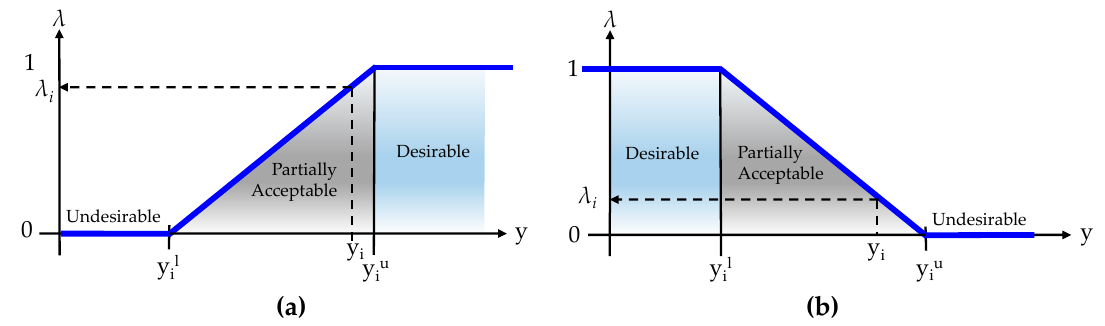
Figure 1. The fuzzy linear membership function for ( a ) maximization, and ( b ) minimization.